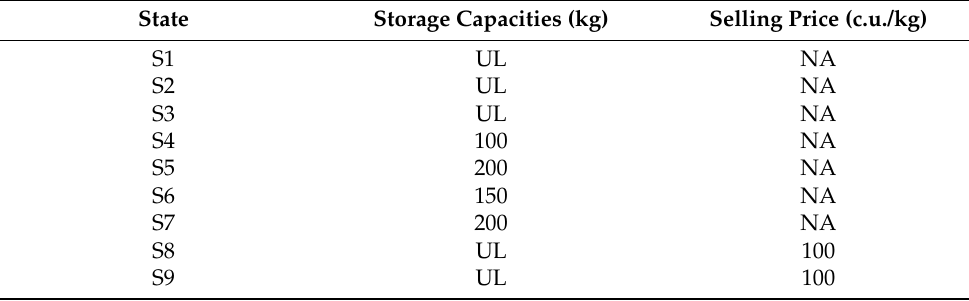
Table A5. Storage limits and the selling price of various states for case study 2 [7].